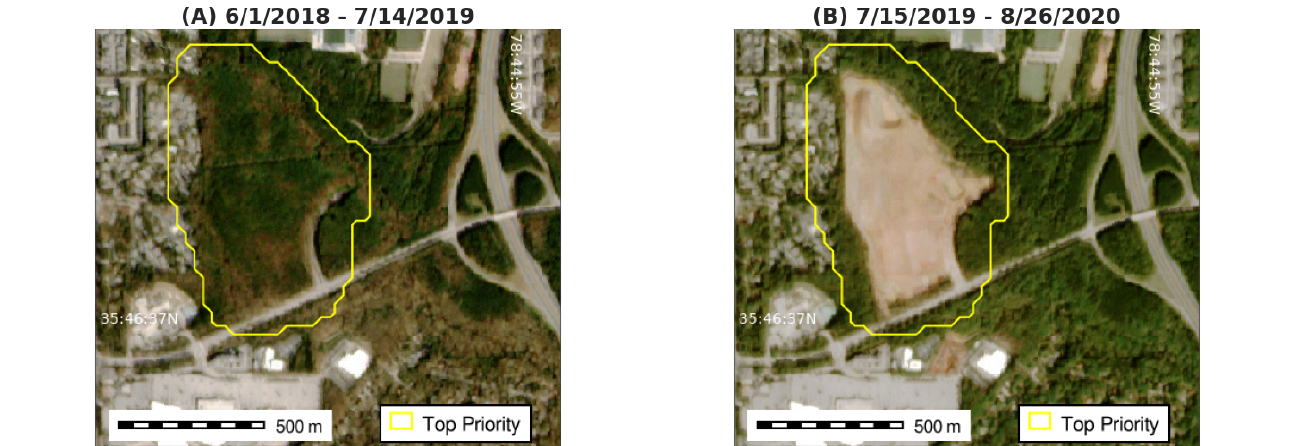
Figure 9. The priority queue vector map shows that Site 1 transitioned from a ( A ) forested area to a ( B ) forest clearing in preparation for new development in the headwaters of the Walnut Creek watershed.